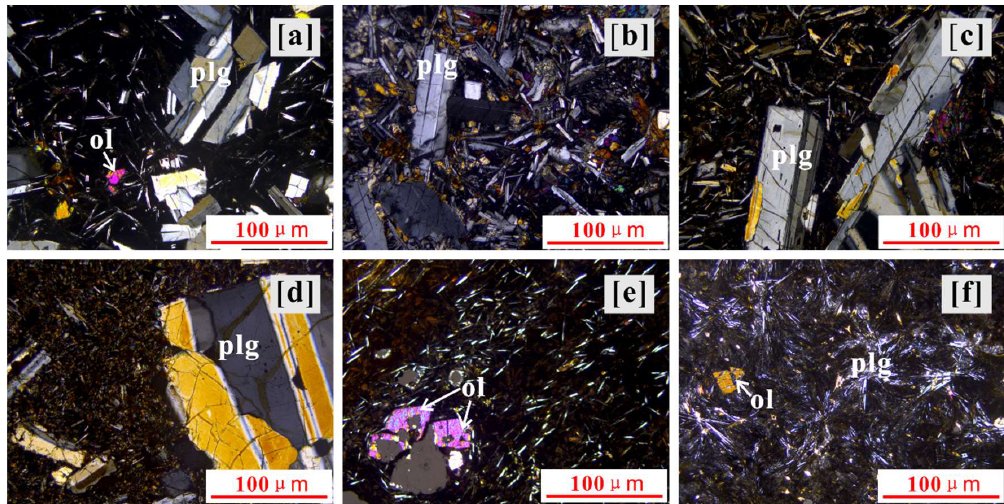
Figure 3. Microscopic observation on the basaltic samples from U1433 and U1434. ( a ) 349-U1433B-65R-2-W,96/98; ( b ) 349-U1433B-68R-3-W,74/76; ( c ) 349-U1433B-70R-2-W,29/32; ( d ) 349-U1433B-72R-1-W,81/84; ( e ) 349-U1434A-12R-1-W,10/15; ( f ) 349-U1434A-13R-1-W,58.5/64.5.